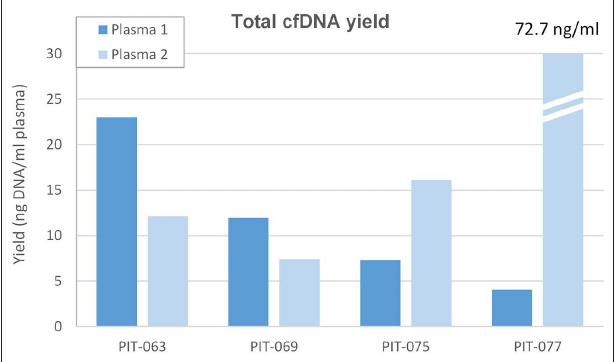
FIGURE 1 | Total cell-free DNA yield. Amount of DNA removed from the first (Plasma 1, concomitant to surgery) and second (Plasma 2, after 3 months therapy) plasma samples, expressed as ng ccfDNA per ml